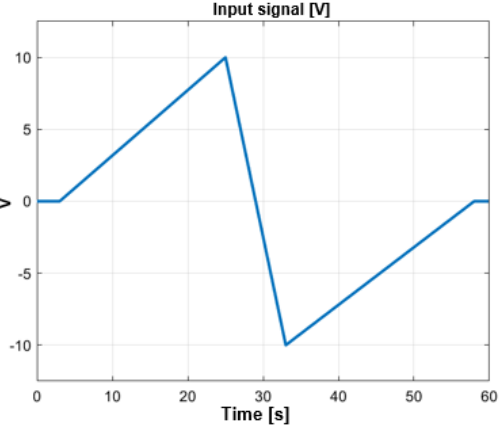
Figure 7. Characteristics of the signal provided by the signal generator (Voltage Signal).